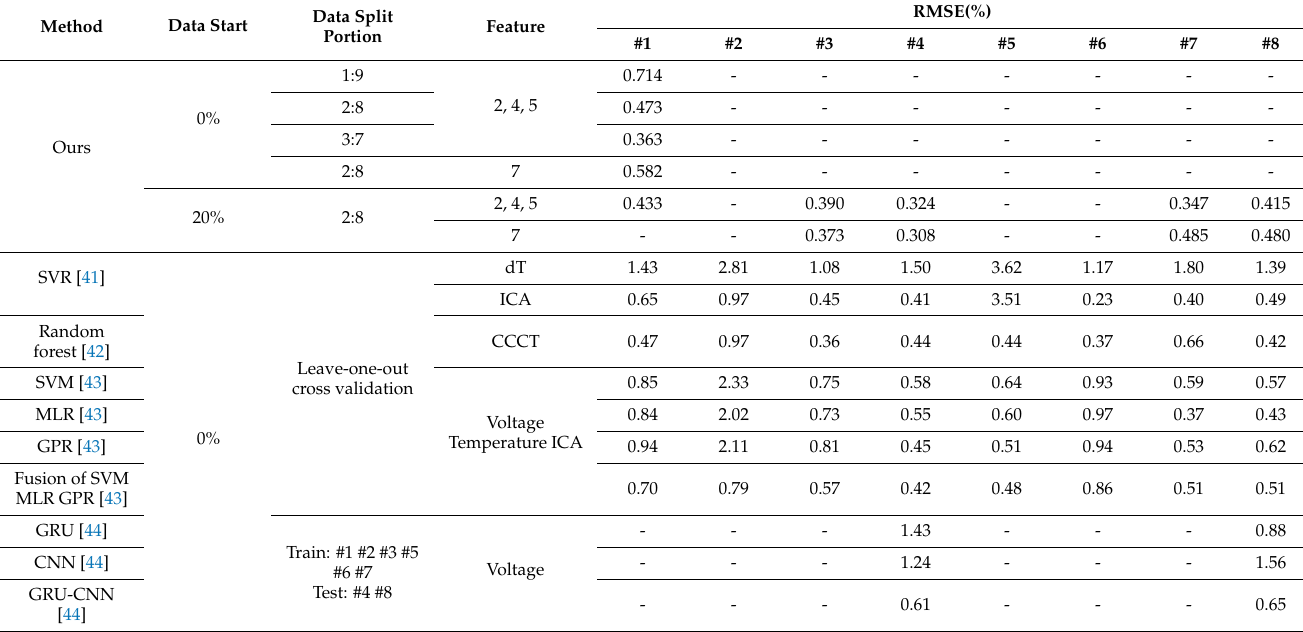
Table 5. RMSE of SOH estimation